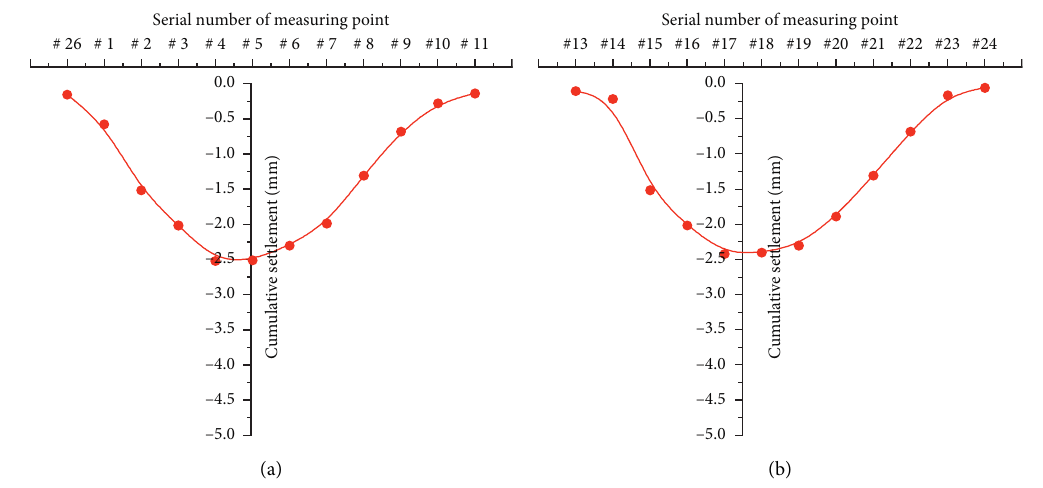
Figure 20: Settlement curve of the diaphragm wall at each measuring point. (a) Measuring point 26–11. (b) Measuring point